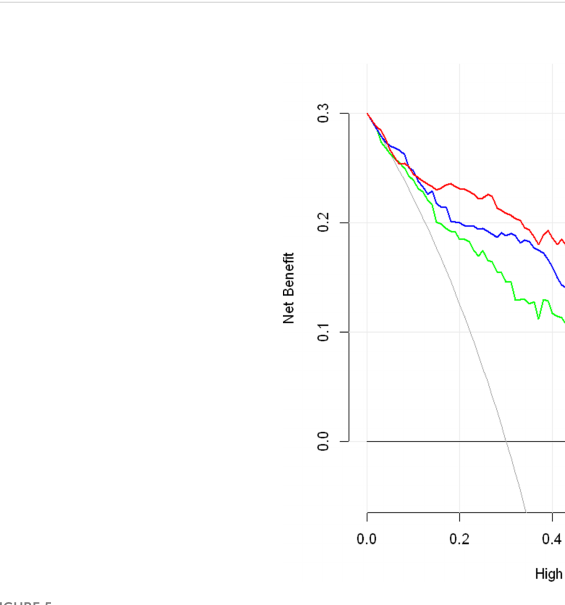
FIGURE 5 Decision curve analysis of the